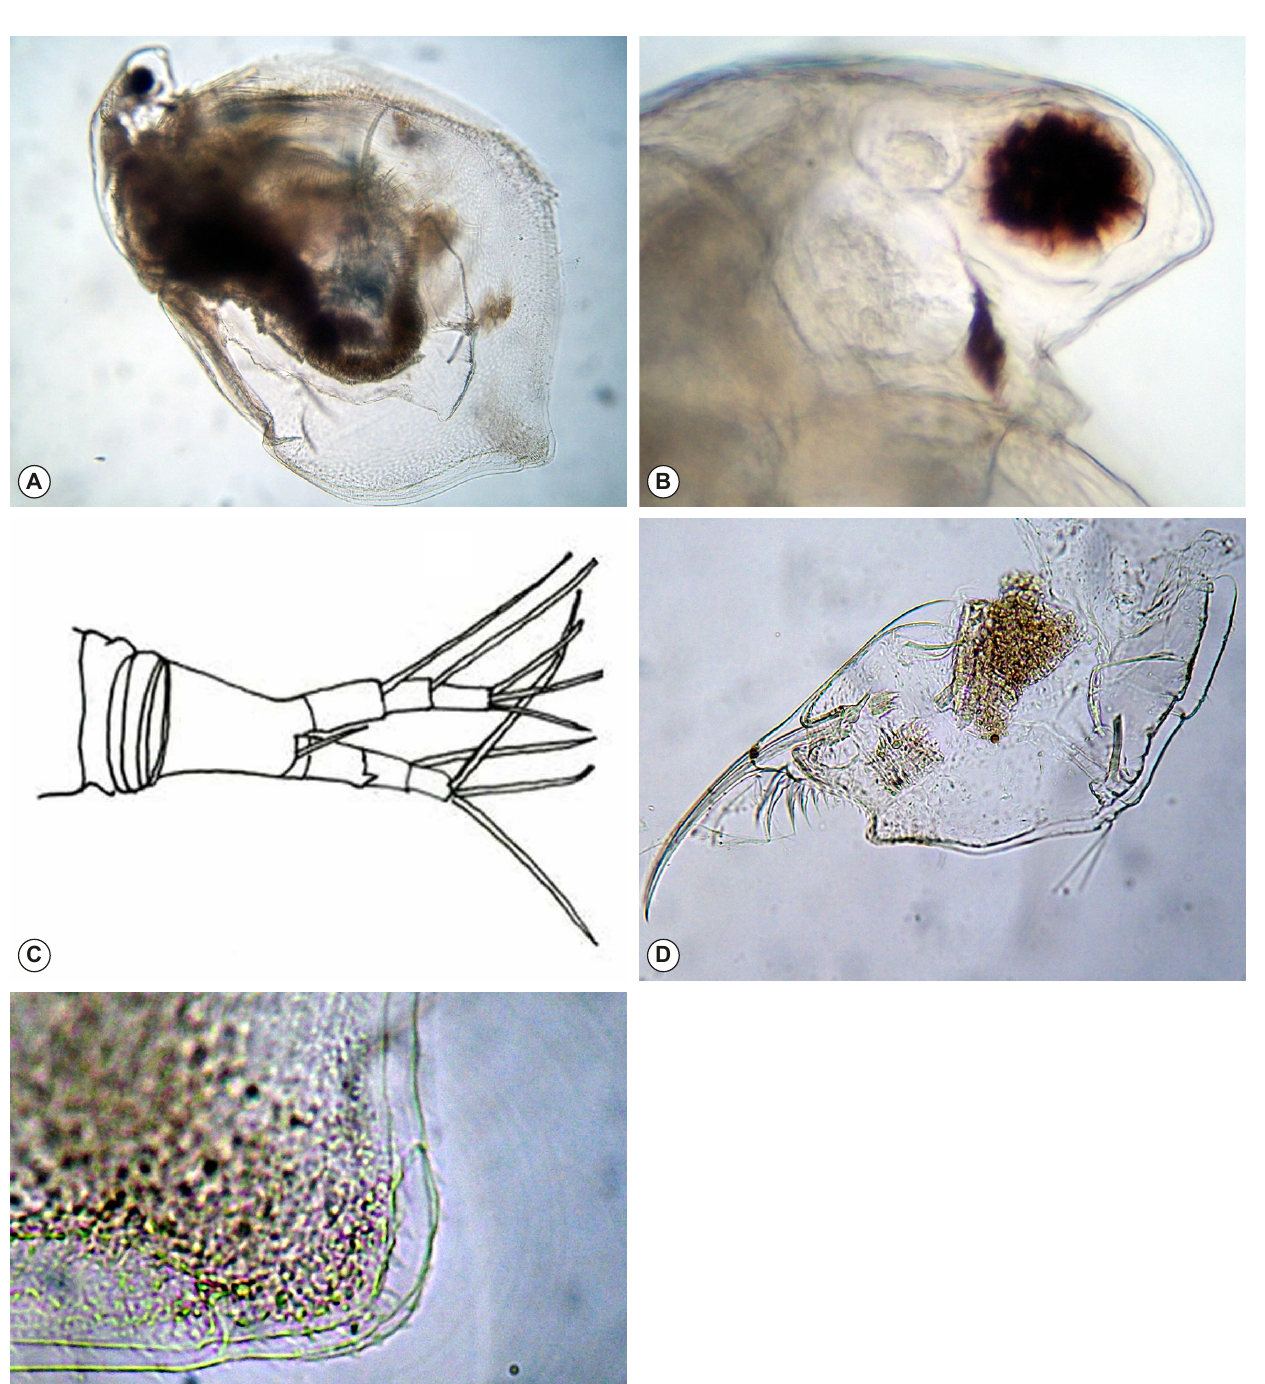
Figure 3. Simocephalus